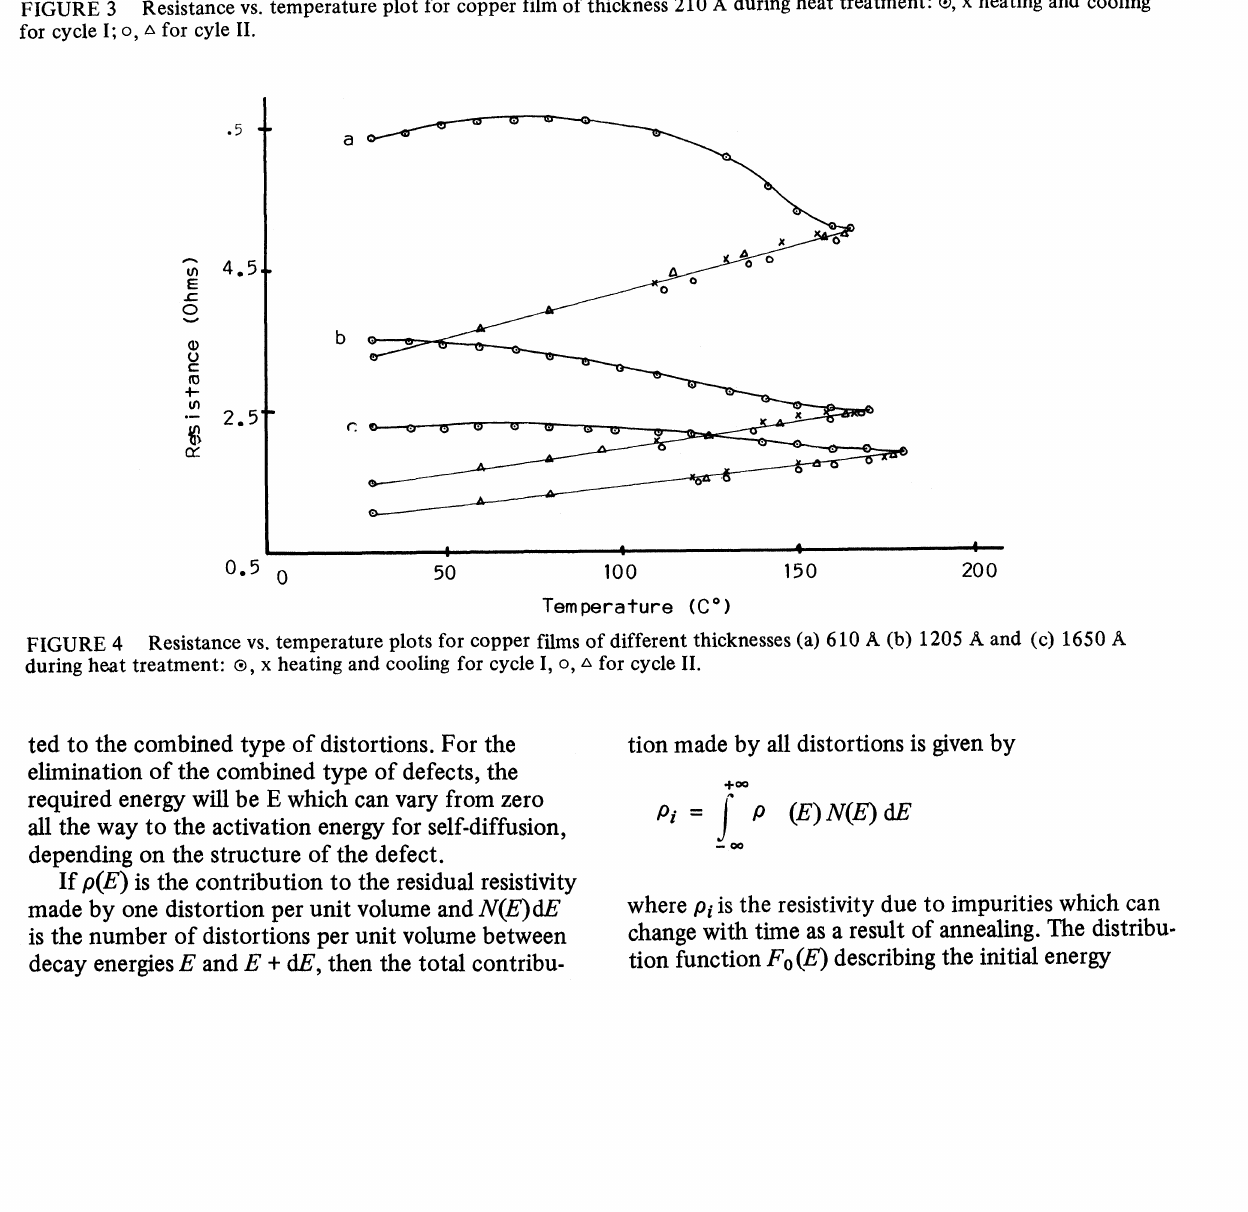
Resistance vs. temperature plot for copper film of thickness 210 A during heat treatment" (R), x heating and cooling for cycle I’o, for cyle II.